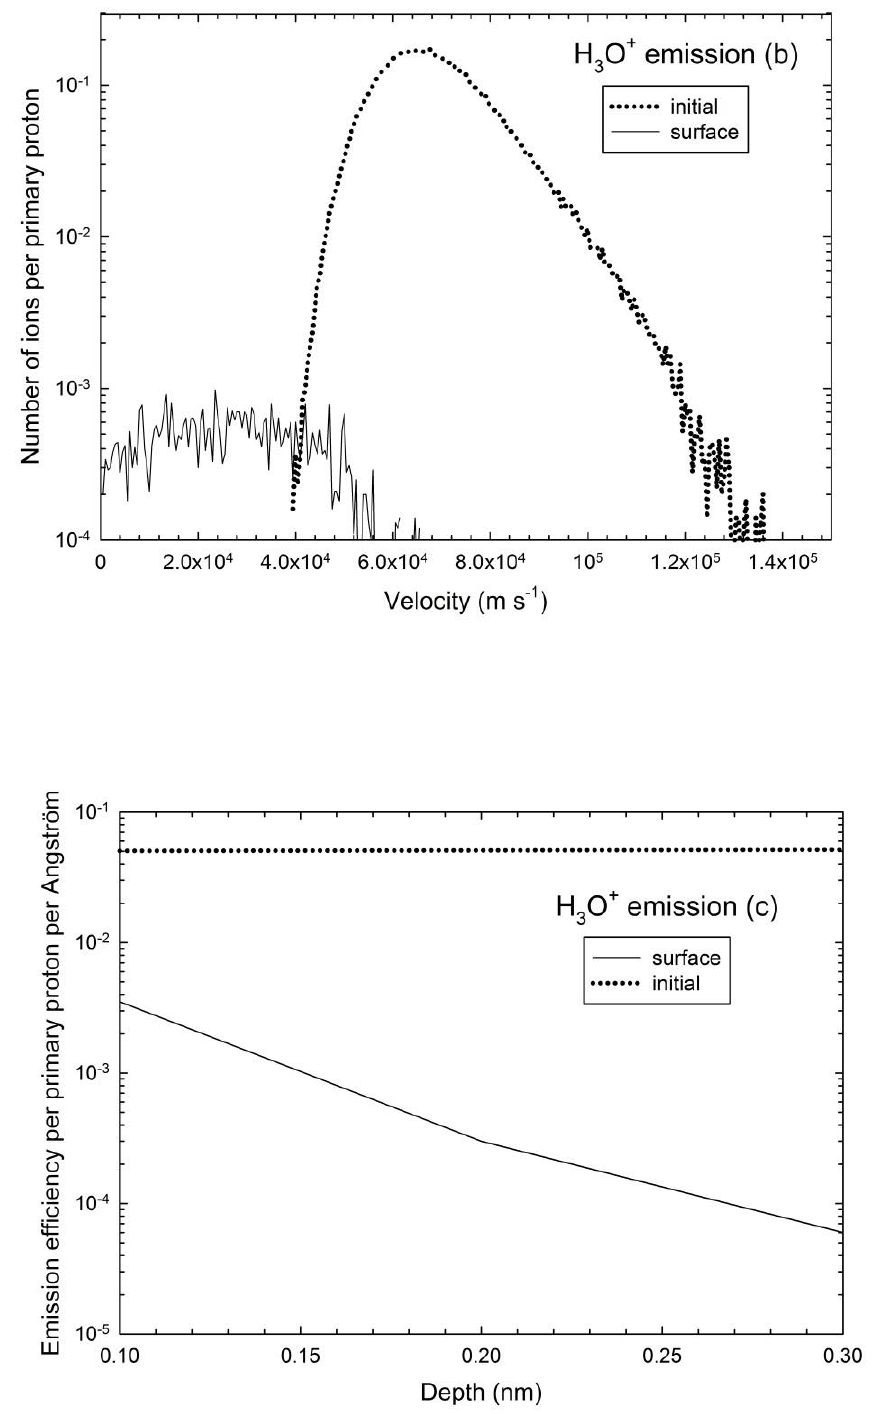
Figure 5. Spectra of generated H 3 O + ions inside water ice as a function of kinetic energy ( a ) and velocity ( b ), computed for 500 neighbor atoms for incident 1-MeV p + : surface distribution (solid curves), initial in-depth distribution (dotted curves). Depth dependence of the emission efficiency or yield per incoming proton and per Å for α = 60° ( c ): produced ions (dotted curve), and emitted ions (solid curve).